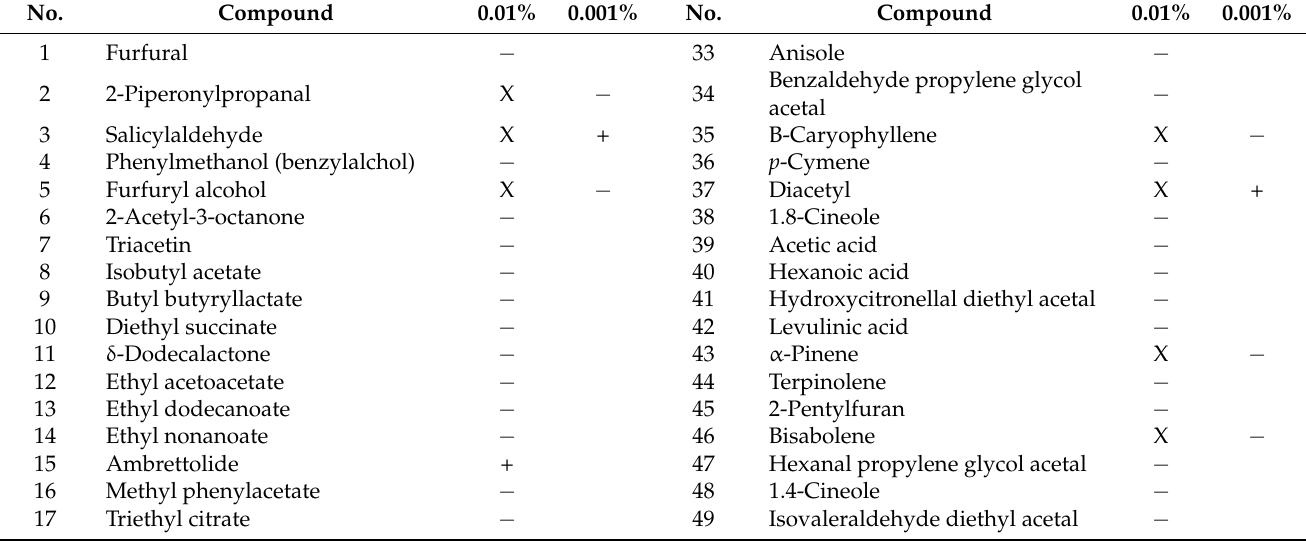
Table 1. List of compounds subjected to